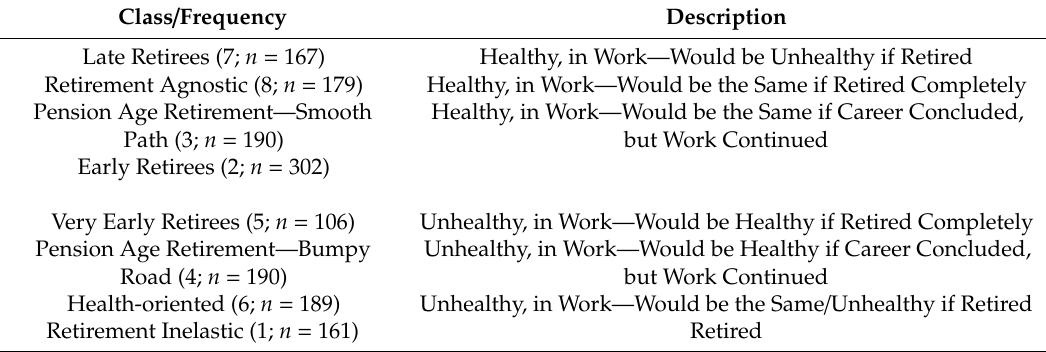
Table 2. Latent Class Descriptions and